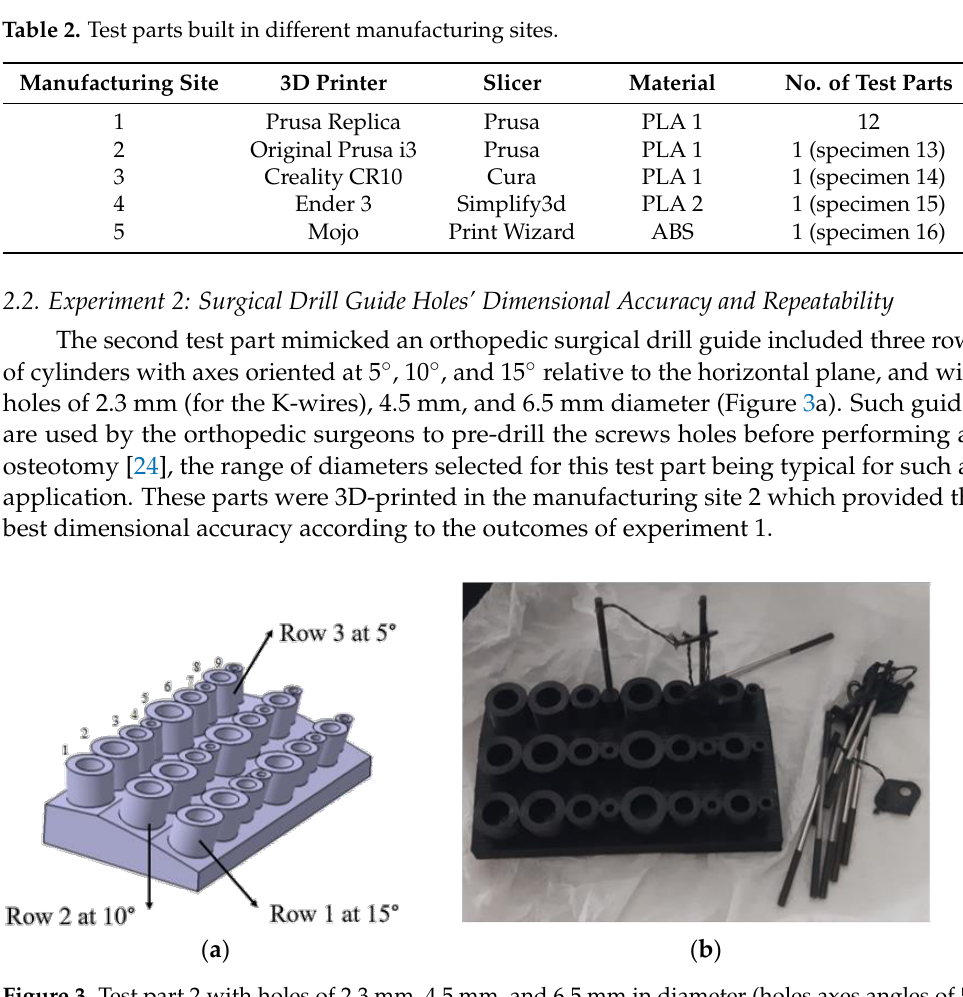
Figure 3. Test part 2 with holes of 2.3 mm, 4.5 mm, and 6.5 mm in diameter (holes axes angles of 5°,